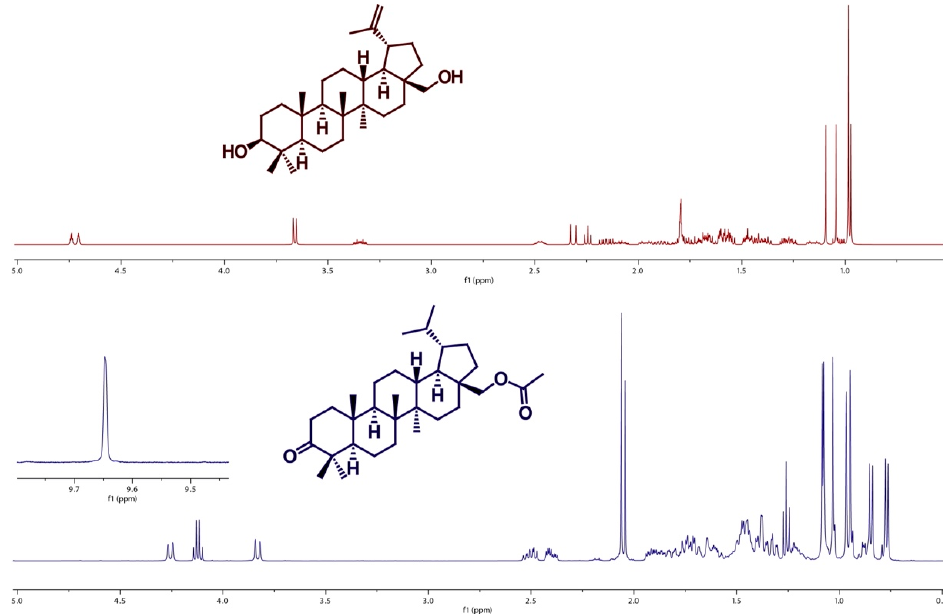
Figure 2. 1 H-NMR spectrum of betulin (above), and its derivative (below).